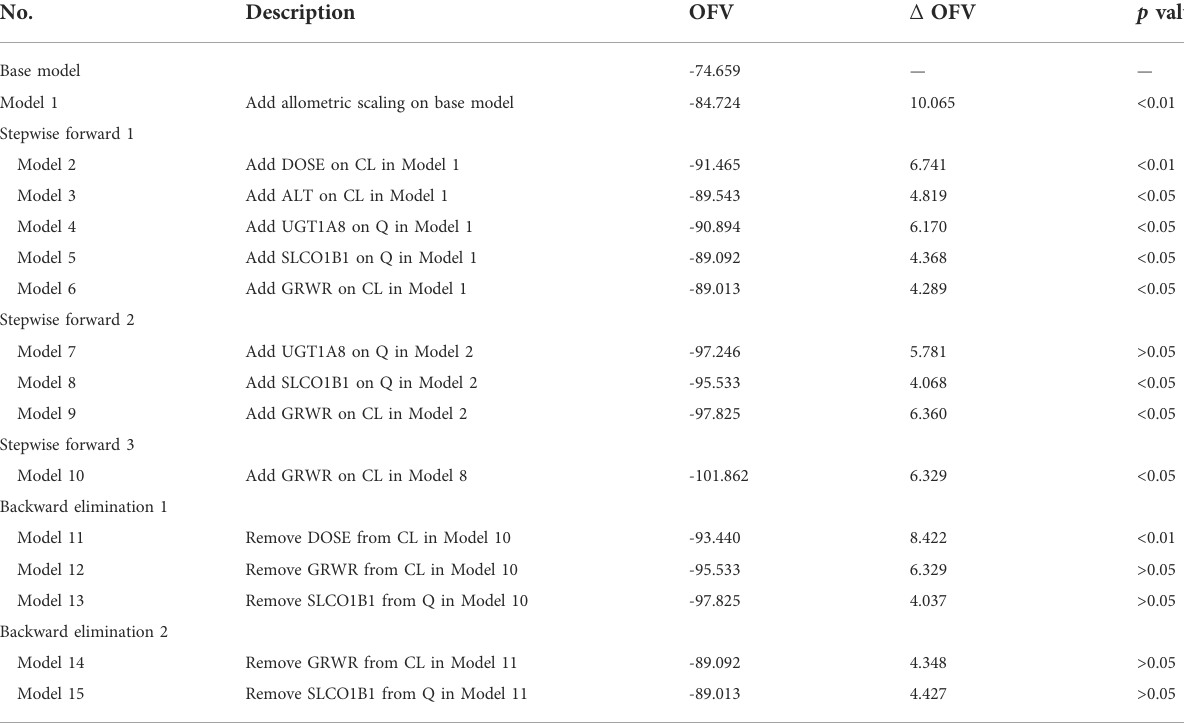
TABLE 2 he process of the fi nal